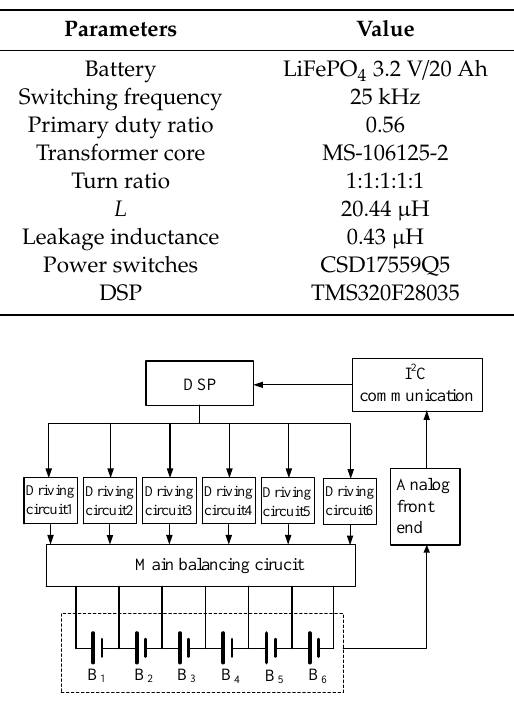
Table 2. Experimental parameters. DSP: digital signal processor.